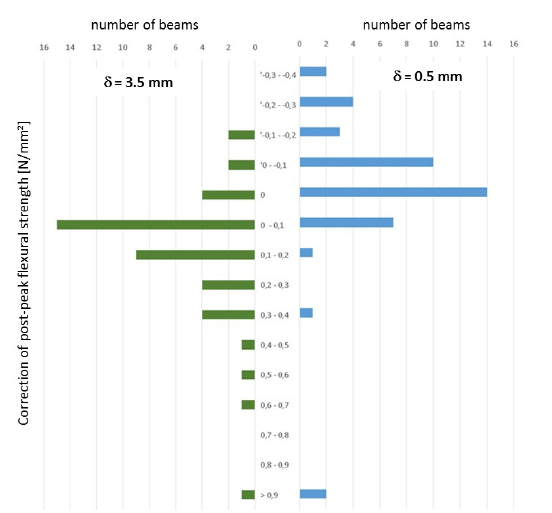
Figure 6. Effect of correction of post-peak flexu- ral strength due to random cracking of beams tested according to DAfStb Guideline